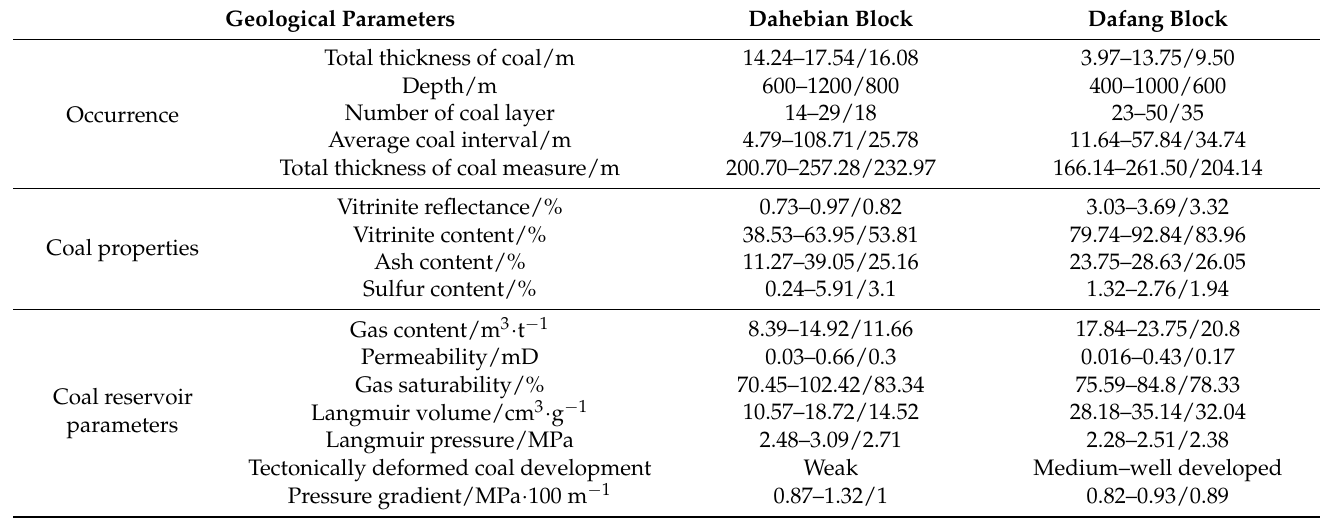
Table 1. Comparison of the representative CBM geological parameters between Dahebian block and Dafang